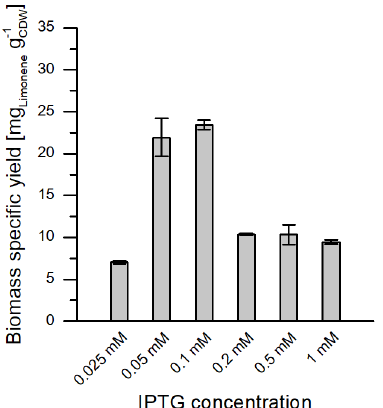
Figure 2. Biomass specific yields for different concentrations of the inducer isopropyl β - d − 1-thiogalactopyranoside (IPTG) after 12 h of cultivation. Two-liquid phase shake flask fermentations with E. coli BL21 (DE3) pJBEI-6410 in M9 minimal medium with 0.5% w / v glucose as the sole carbon source. The error bars relate to biological duplicates.